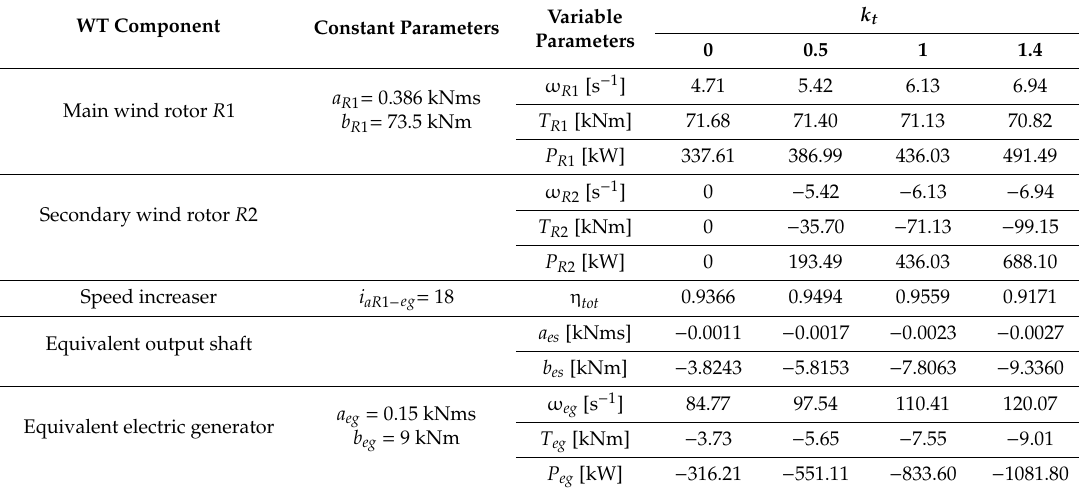
Table 2. Functional parameters of the wind turbine in steady-state